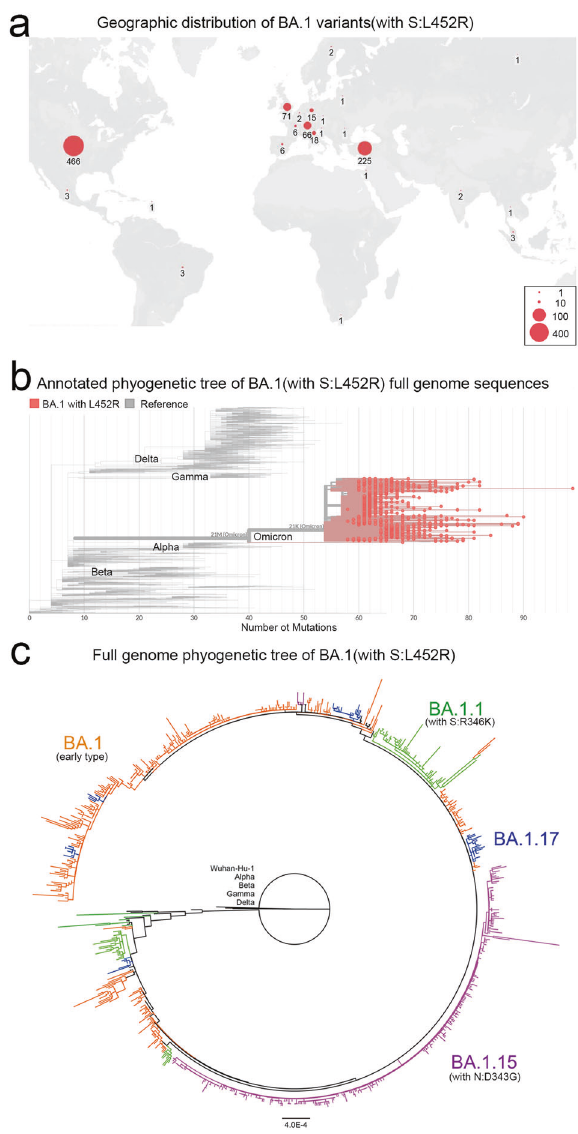
Fig. 4 Geographic distribution and whole genome analyses of “ Delatcron ” -like BA.1 subvariants (with S:L452R mutations). a Geographic distribution of “ Delatcron ” -like BA.1 subvariants (with S:L452R), with the number of genome sequences noted. b Whole genome annotation of amino acid mutations highlighting the “ Deltacron ” -like BA.1 subvariants (with S:L452R). 897 full genome sequences of BA.1 with S:L452R mutation were shown with red circles. c Phylogenetic analysis of the “ Deltacron ” -like BA.1 subvar- iants (with S:L452R). Maximum likelihood tree was constructed using Iqtree2 with 1000 bootstrap replicates and TIM + F + R3 model. Low quality sequences were excluded. 897 SARS-CoV-2 BA.1 full genome sequences with S:L452R mutation submitted to the GISAID database before 15 January 2022 and reference sequences from VOCs were included. Pango sublineages BA.1, BA.1.1, BA.1.15, and BA.1.17 are marked in